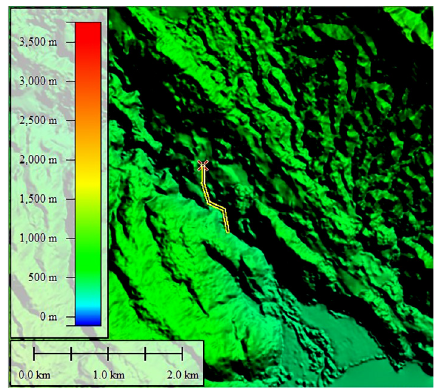
Figure 17. The latest DTM in Semangko fault in 2020